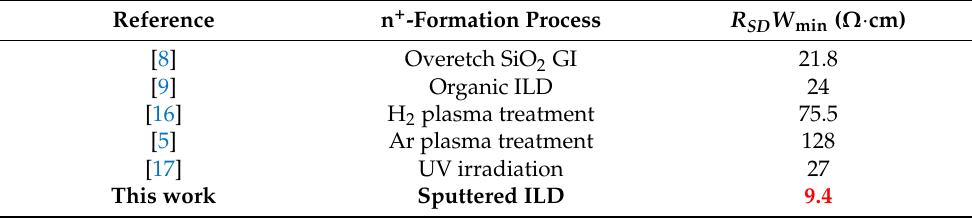
Table 1. Benchmark of minimum R SD W for IGZO TFTs with different n + -formation